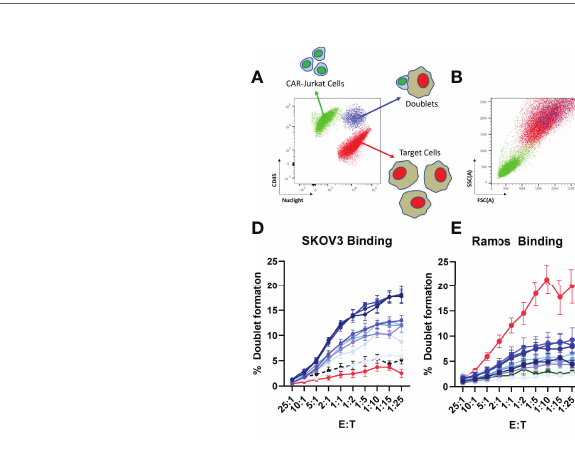
FIGURE 4 | Hinge truncation progressively diminishes CAR-cell binding with target cells. Jurkat cells with stable expression of sdAb021 EGFRsdCAR were generated through lentiviral transduction and cell sorted for similar surface expression. EGFR-sdCAR-Jurkat cells were then mixed at varying doses with mKate2-expressing target cells and co-incubated for 30 minutes at 37°C. (A) Flow cytometry was used to assess the number of CAR-Jurkat cells, target cells, and CAR-Jurkat/target doublets. (B) Examining the size/granularity parameter shows that doublet cells (blue) appear similar in size to the larger target cell population. (C) Examining the height/width parameter indicates that identi fi es the doublet population as wider than the target cells alone (blue vs red). The proportion of CAR-Jurkat cells engaged in doublet formation with (D) EGFR-high SKOV3 cells or (E) EGFR-negative Ramos cells were quanti fi ed using gating as described in the main text. (F) The target cell binding across varying hinge constructs at a fi xed effector:target ratio of 1:5 is shown. Graphs show the mean +/- SEM from three experiments performed in